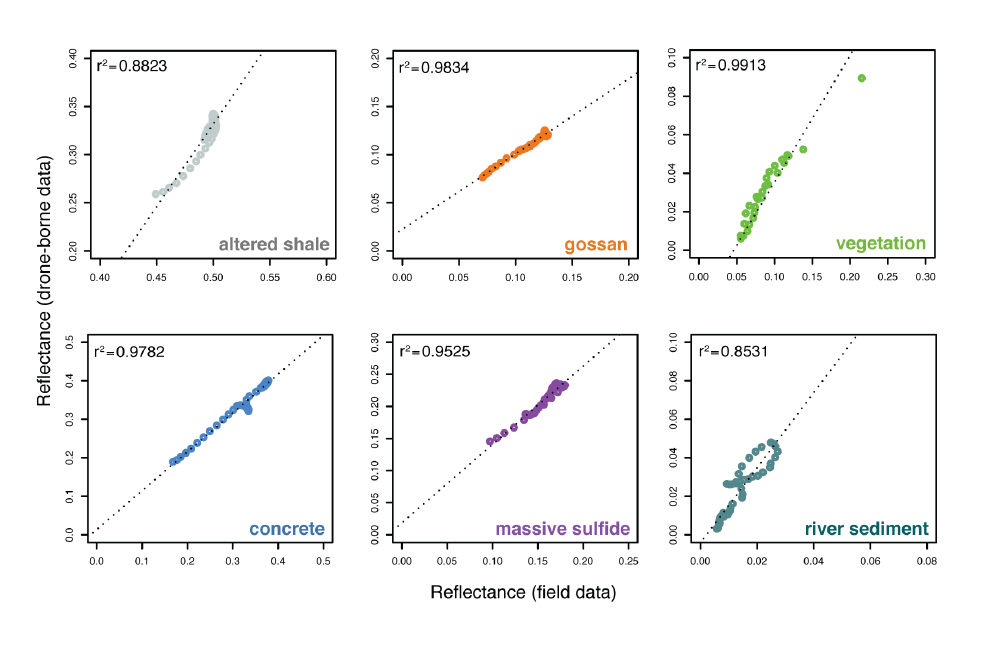
Figure 8. Correlation of the reflectance values of field spectra and drone-borne HSI data for six sample target